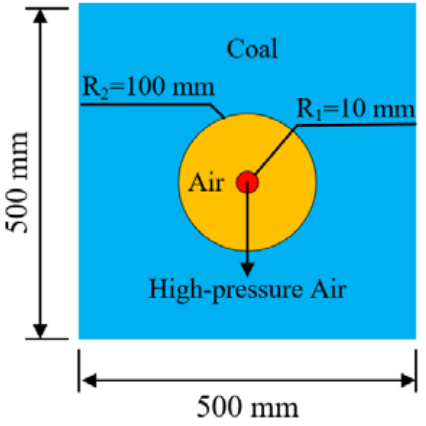
Figure 2. Numerical model of HPAB.